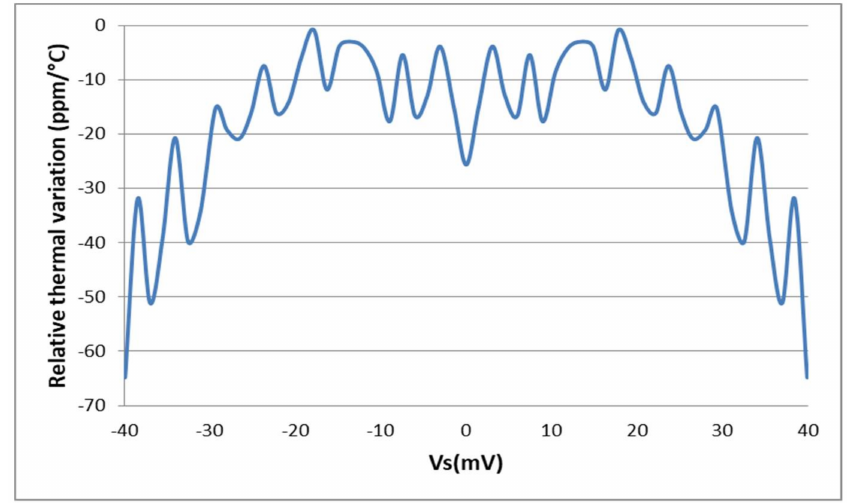
Figure 19. Measured relative thermal variation of the sensor